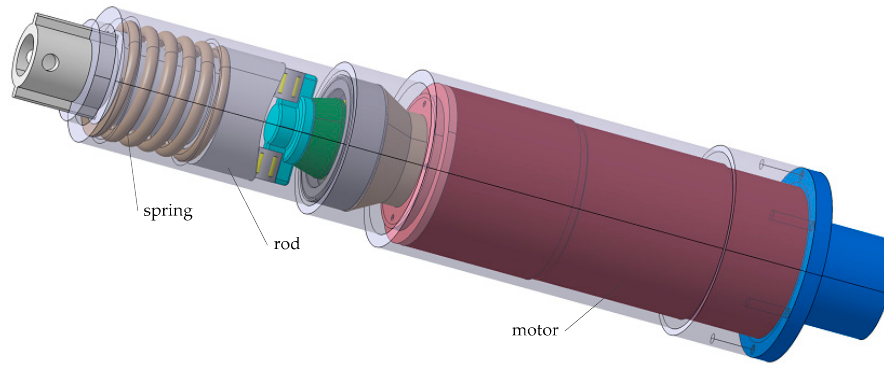
Figure 3. The actuator.